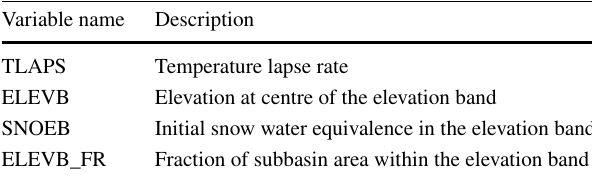
Table 2 SWAT input variables to estimate snowmelt runoff